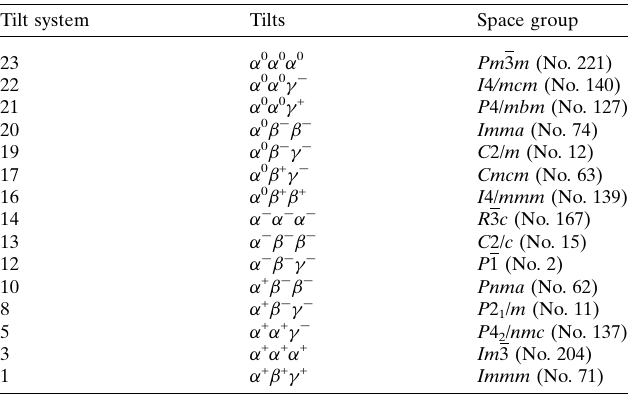
Table 1 For each of the different Glazer tilt patterns we provide the index as assigned by Glazer (1972, 1975), the tilts given with Glazer notation and the space group symmetry of the resulting phase. Note we have only included the tilt systems that are